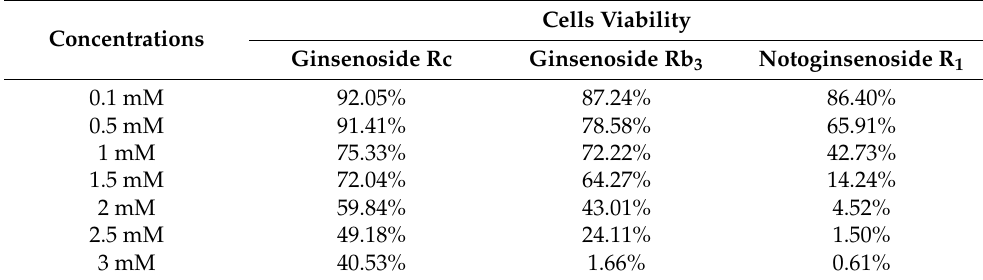
Table 1. MTT assay in A549